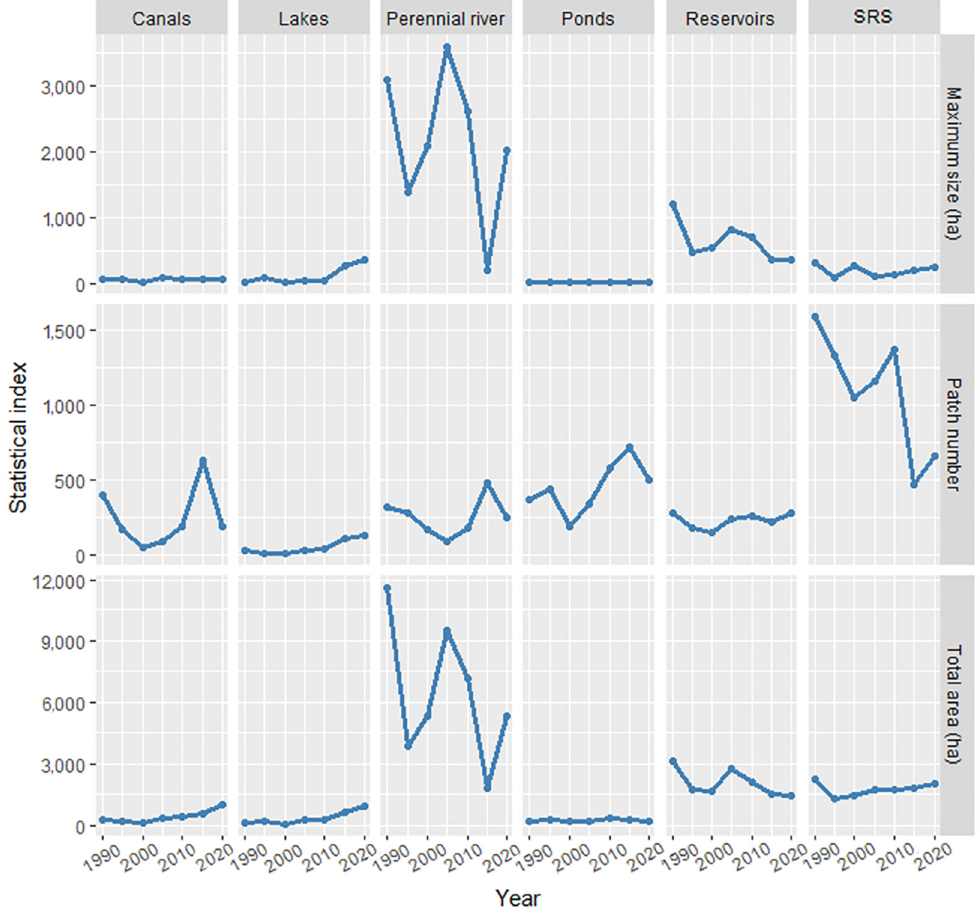
Figure 3. Spatiotemporal distribution of waterbodies in Zhengzhou from 1990 to 2020. ( top row ) The size of the largest individual waterbody in each category; ( middle row ) the number of waterbodies in each category; ( bottom row ) the total surface area of all waterbodies each category. SRS is an abbreviation for seasonal rivers and streams.